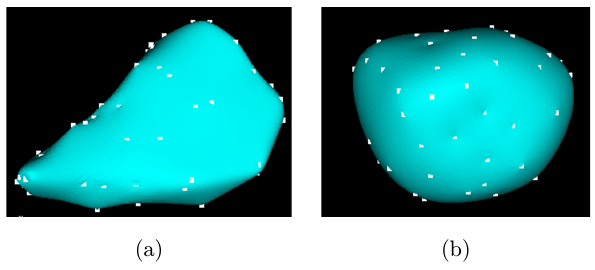
Fig. 4. Original three-dimensional spiral CT damage image.